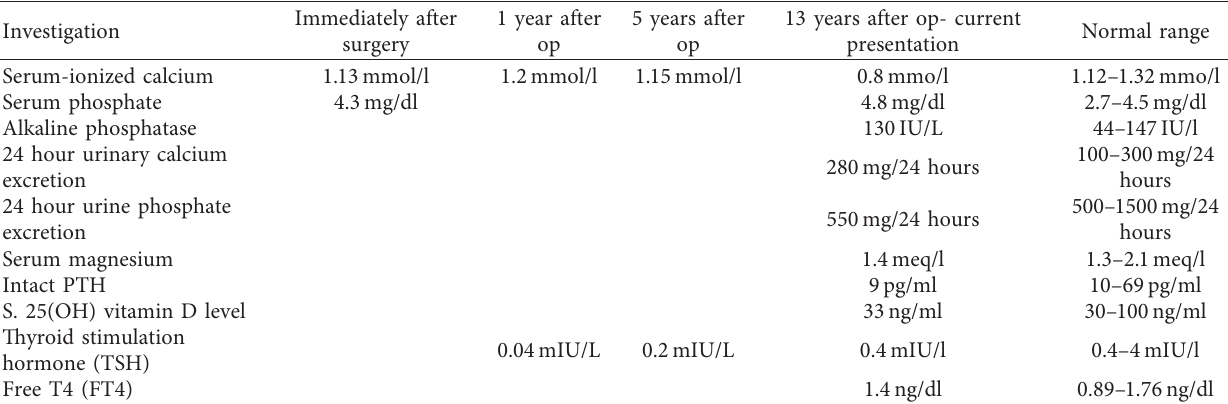
Table 3: Summary of investigations of case